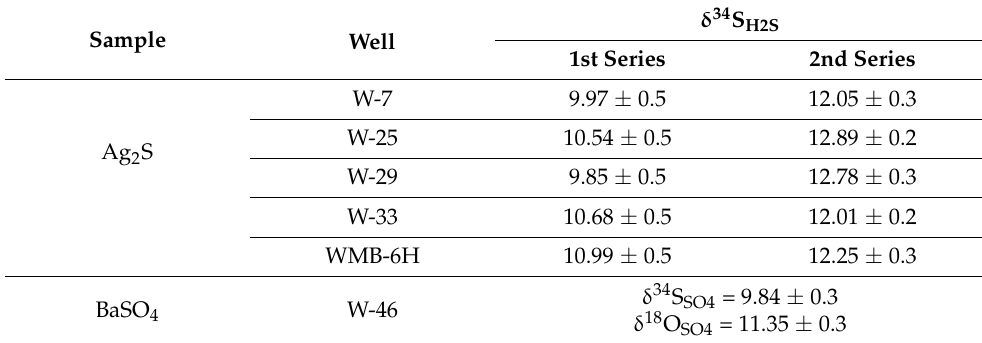
Table 6. Results of the isotope analyses δ 34 S H2S for the natural gas samples from the selected UGS Wierzchowice wells and δ 34 S SO4 i δ 18 O SO4 for the depth water sample from the W-46